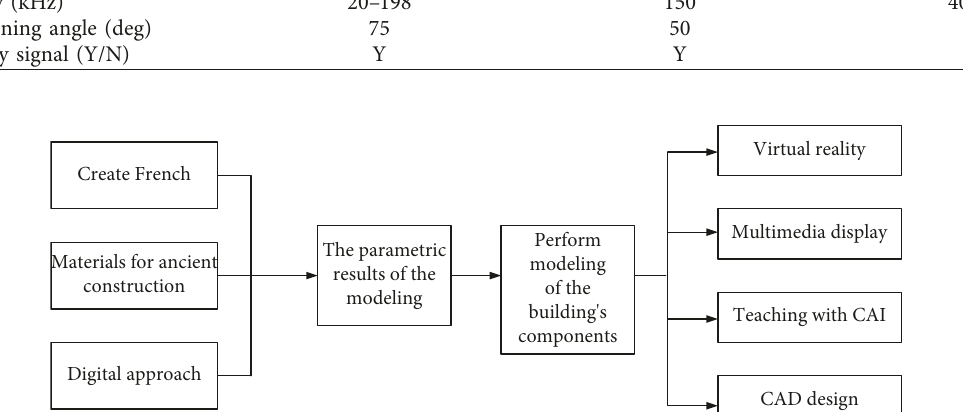
Figure 2: System implementation process.